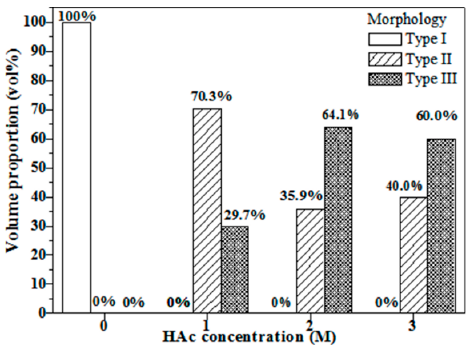
Figure 4. Statistical measurements of morphology types of untreated and HAc-treated BG powders.